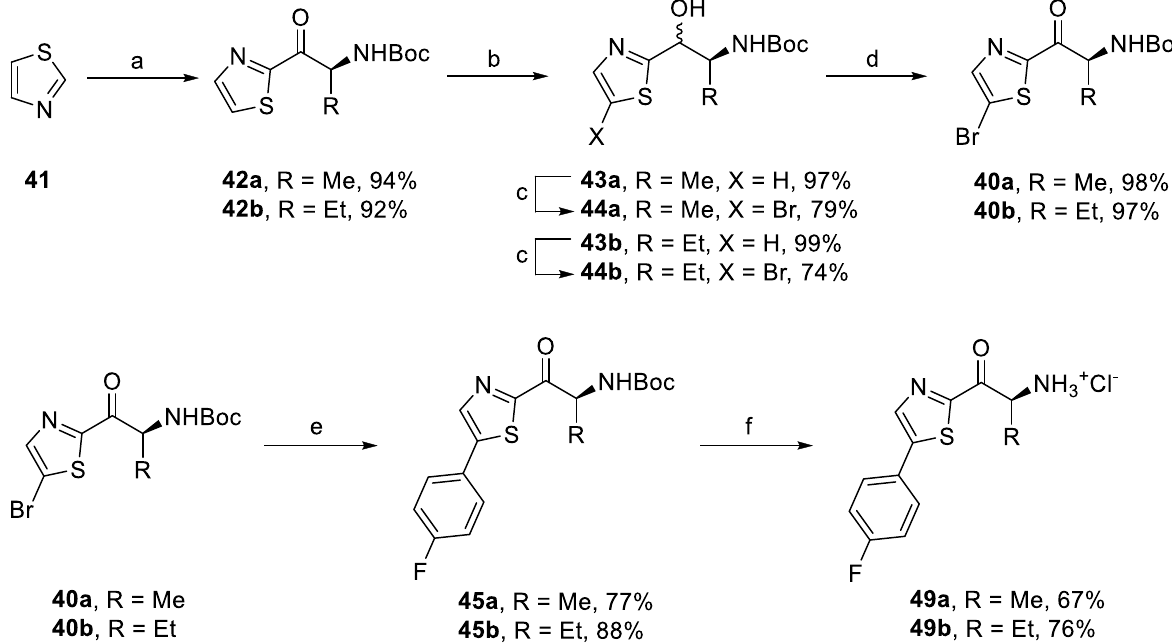
Figure 13. Synthesis of aryl-thiazole derivatives based on SAR. Reagents and conditions: (a) 14 or 23e , i- PrMgCl.LiCl, − 10 °C – r.t.; (b) NaBH 4 , MeOH/THF, 0 °C – r.t.; (c) NBS, DMF, 0 – 50 °C; (d) DMP, DCM, r.t.; (e) (4-fluorophenyl)boronic acid, XPhos Pd G2, K 3 PO 4 , THF/H 2 O, 40 °C; and (f) AcCl, MeOH, 0 °C – r.t.